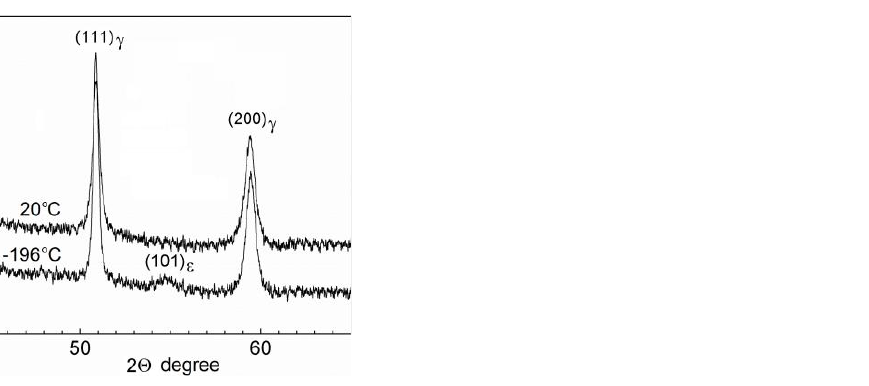
Figure 3. Fragments of XRD diffraction patterns of Cr-Mn-N steel after the tensile tests at T = 20 °C and T = −1 96 °C.